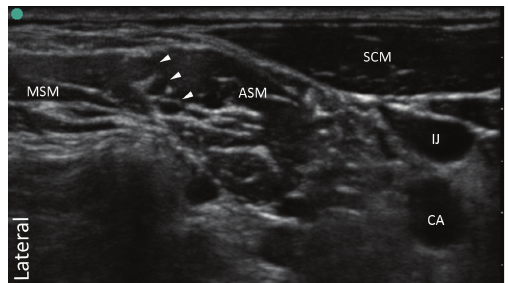
Figure 3: Ultrasound probe position for the interscalene brachial plexus block.